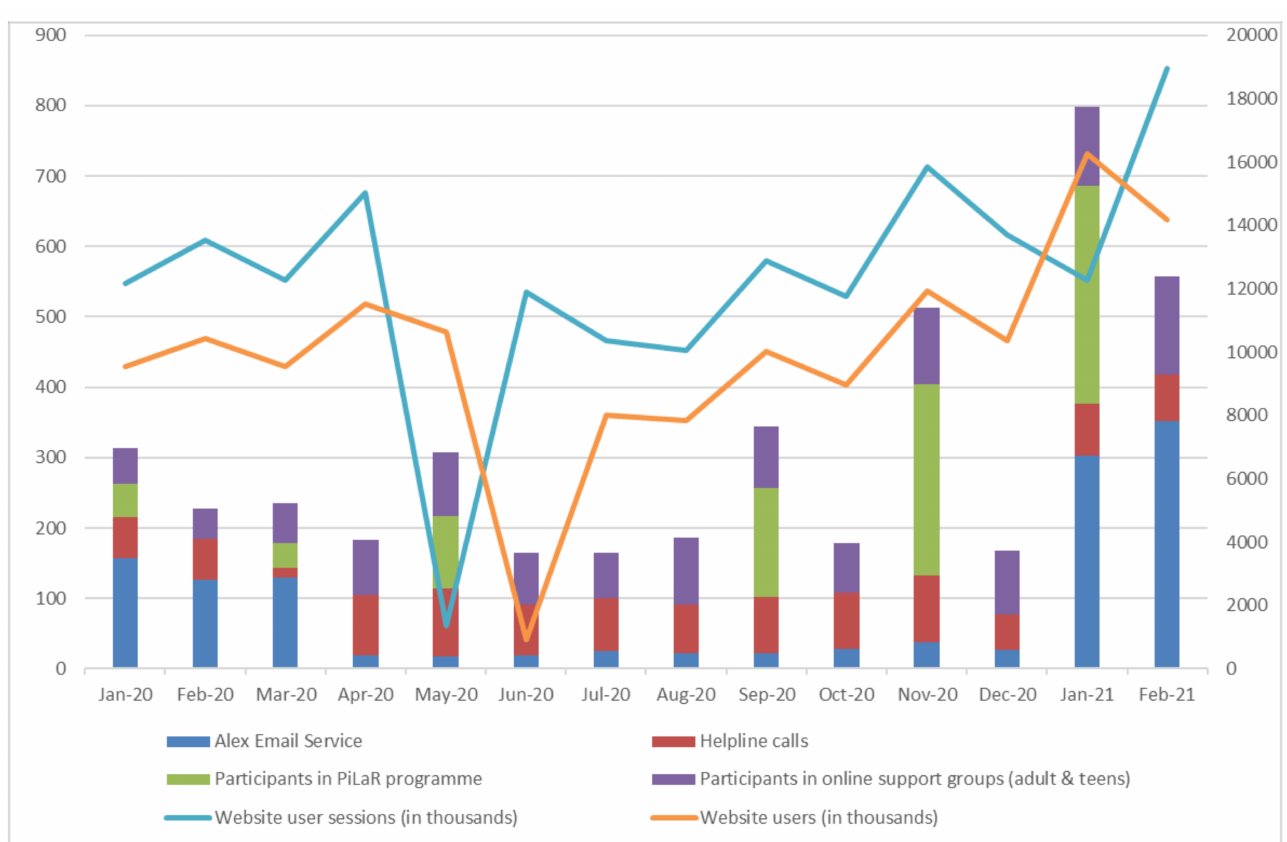
Figure 1. Number of people using Bodywhys’ support services from January 2020 to February 2021. Data sourced from Salesforce and Google